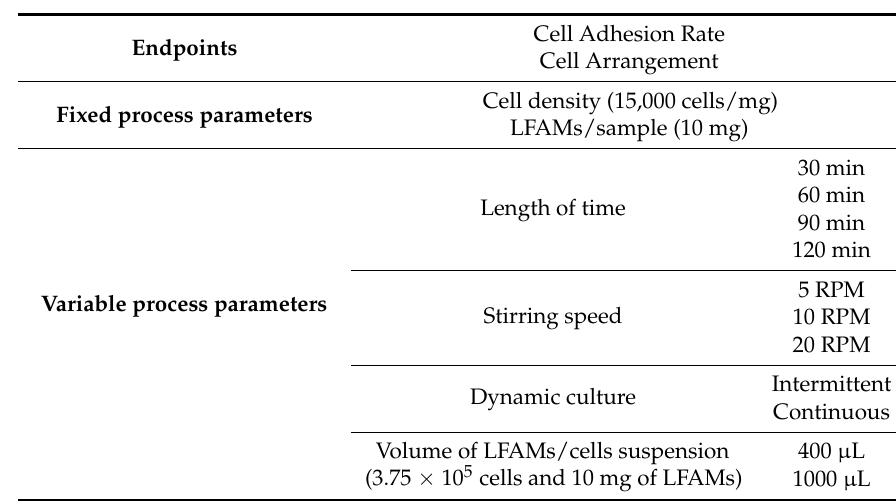
Table 1. Endpoints of the study. Setting up of fixed and variable parameters. LFAMs = lyophilized fibroin-coated alginate